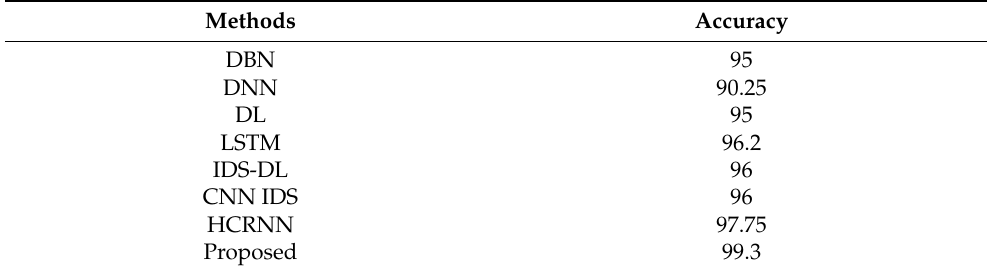
Table 4. Accuracy analysis using dataset 3.